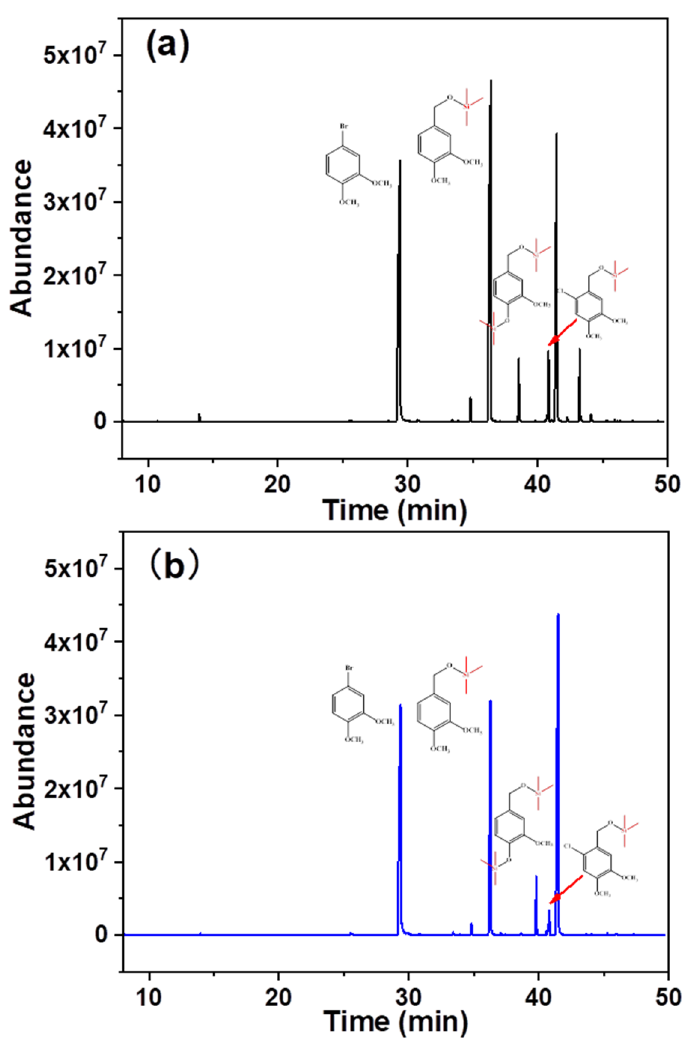
Figure 4. Product composition under different chlorine dioxide oxidation conditions ( a ), traditional chlorine dioxide oxidation; ( b ), optimized oxidation of chlorine dioxide. Table 1. Hydrolysate components under different chlorine dioxide oxidation conditions.